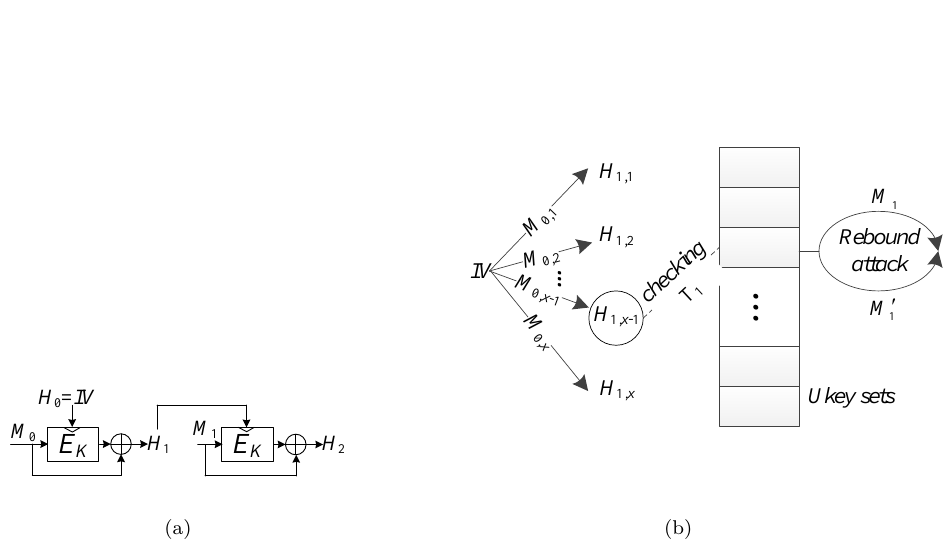
Figure 5: (a) MMO Hashing Mode with Two Blocks, (b) The Whole Collision Attack